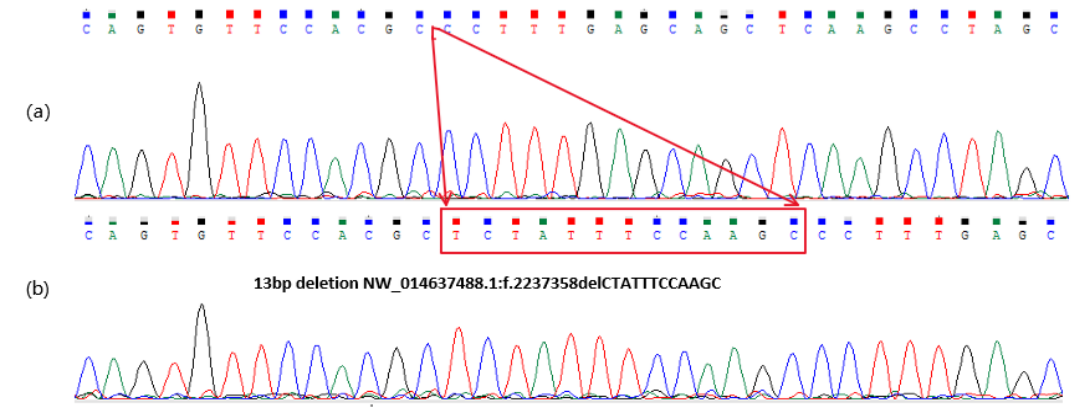
Figure 1. Chromatogram of the 13 bp deletion of the donkey NR6A1 gene. ( a ) Homozygotic deletion/deletion type (DD) of the NR6A1 locus; ( b ) homozygotic insertion/insertion type (II) of the NR6A1 locus. The sequence with the red line boundary is the 13 bp deletion.